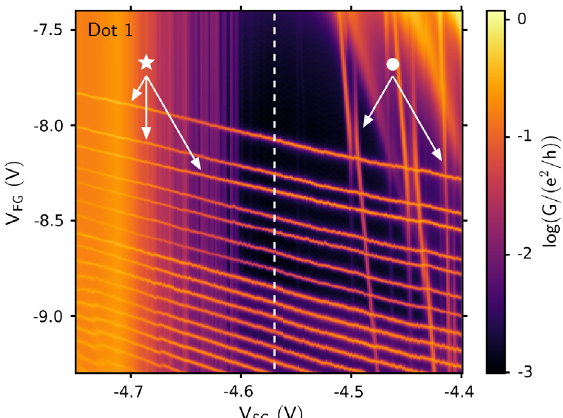
FIG. 6. Logarithmic two-terminal conductance as a function of the split gate voltage V and the finger gate voltage V SG ¼ 5 . 55 V. The cut along the dashed line 1 measured at V BG corresponds to Fig. 2(a).